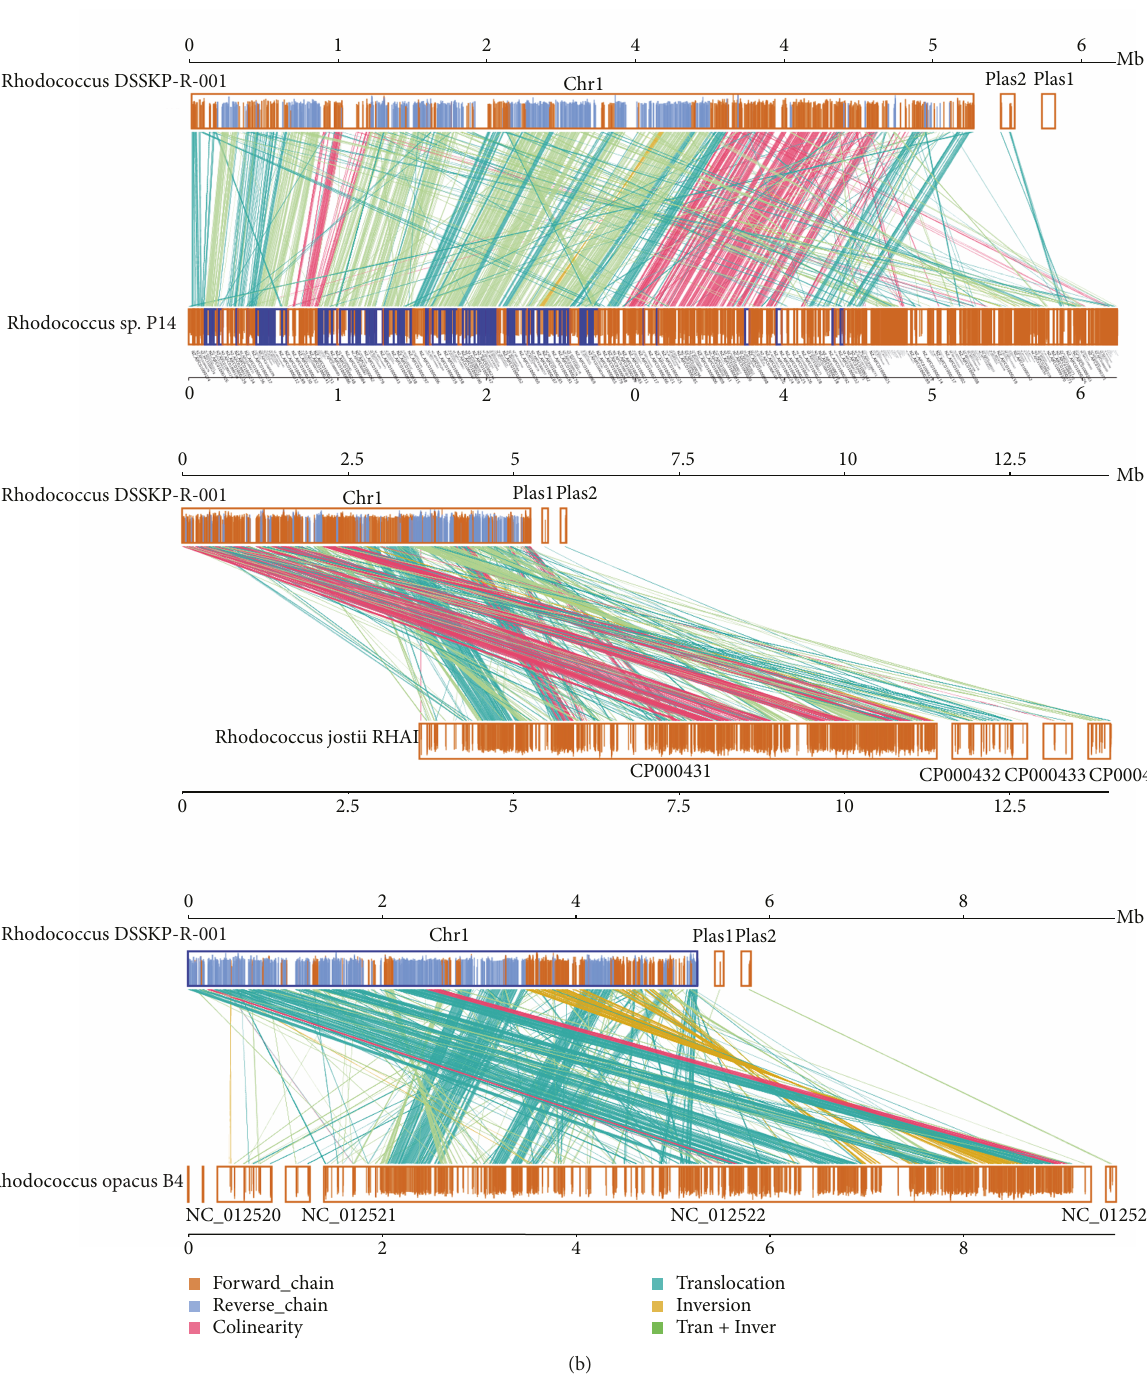
Figure 8: The results of whole genome collinearity. (a) Whole genome two-dimensional collinearity display. The horizontal and vertical axes of the fi gure correspond to the whole genome (vertical axis sequence name in the upper right corner of “ ∗ ” means the use of the sequence of negative pairs); lines represent positive alignment, and blue indicates reverse alignment. The middle of the box color matches the type: Collinear: with linear comparison; Translocation: translocation comparison; Inversion: inverted comparison; and Tran + Inver: translocation and inverted comparison. (b) Whole genome parallel collinearity display. The upper axis and lower axes represent the corresponding whole genome. The yellow box on the upper and lower axes shows the genome forward chain, the blue box represents the genomic reverse chain, the height of the fi lled color in the box indicates the similarity of the alignment, and full fi lling indicates a similarity of 100%; the link between the upper and lower axes. The color of the alignment type: Collinear: the same linear comparison; Translocation: translocation comparison; Inversion: inverted comparison; and Tran + Inver: translocation and inverted